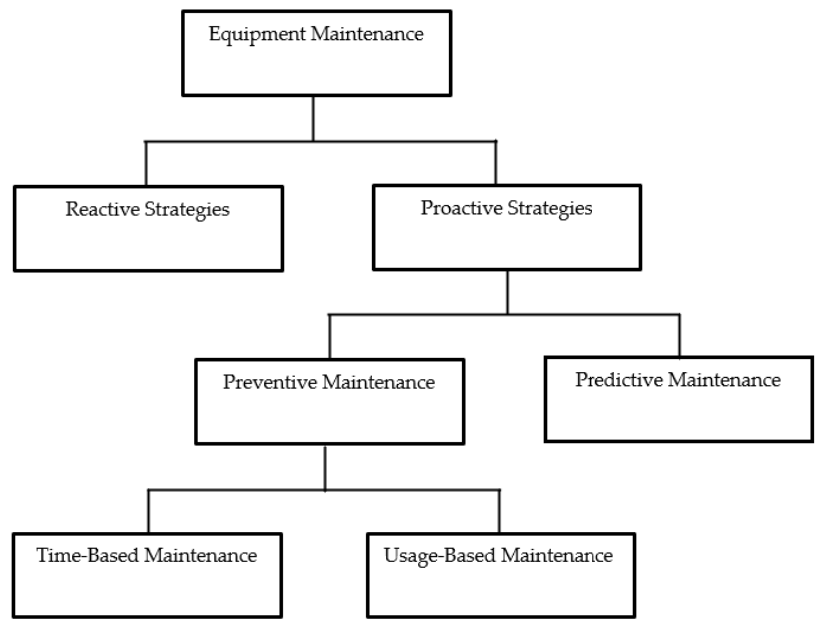
Figure 2. Taxonomy of equipment maintenance policies in industrial maintenance.